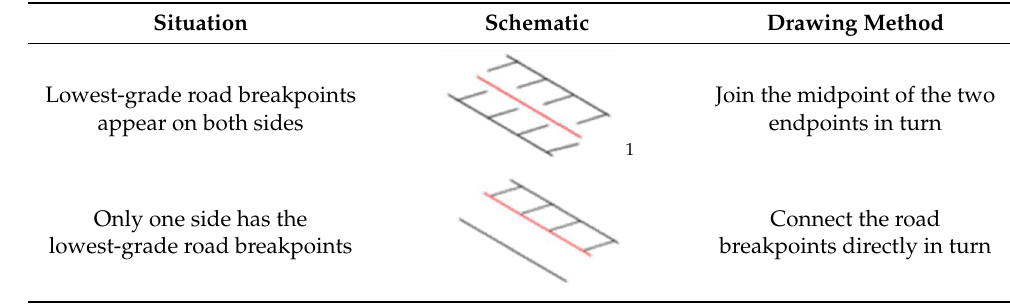
ISPRS Int. J. Geo-Inf. 2022 , 11 , x FOR PEER REVIEW 8 of 15